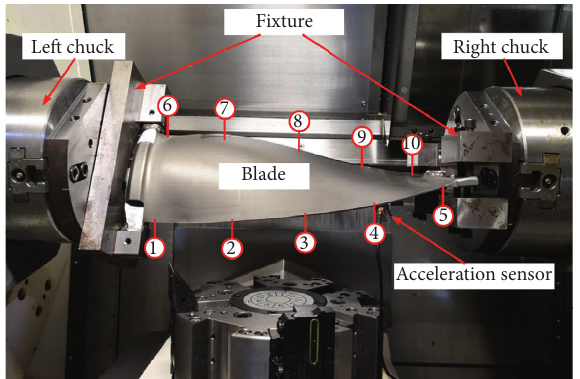
Figure 2: Setup of impact